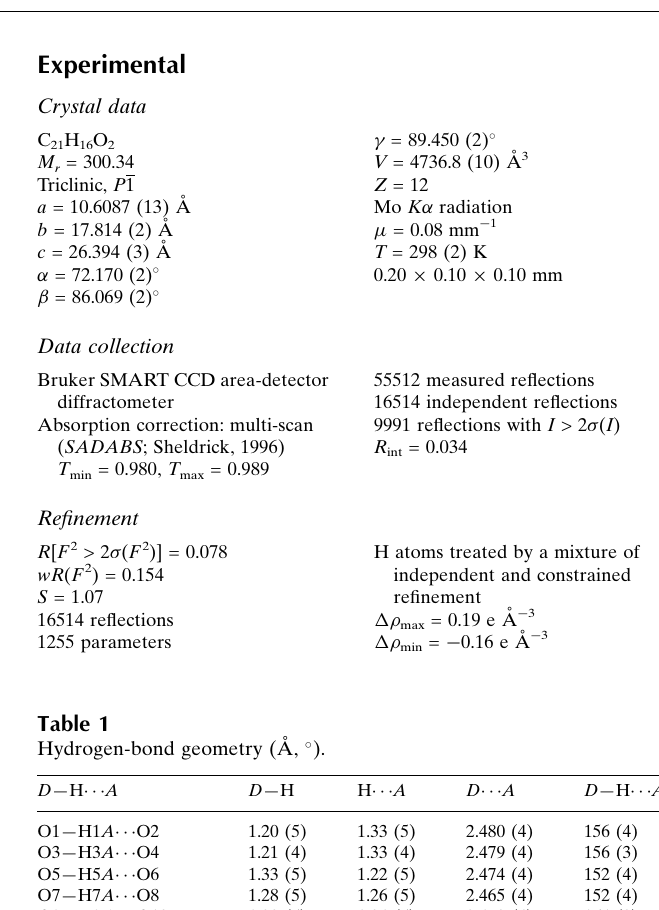
very weak non-conventional intermolecular